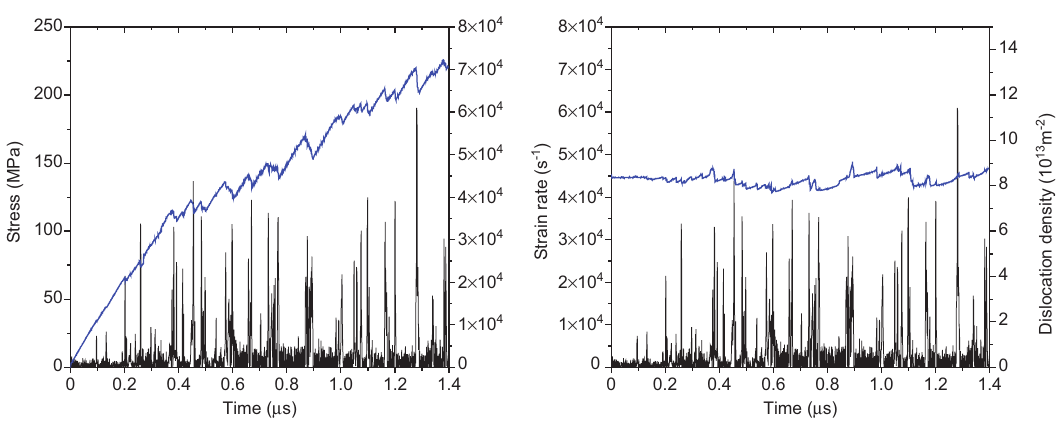
Figure 9 Stress, strain rate, and dislocation density vs. time signals in a DDD simulation of uniaxial compression. Left, Stress vs. time and strain rate vs. time; right, dislocation density vs. time and strain rate vs. time.